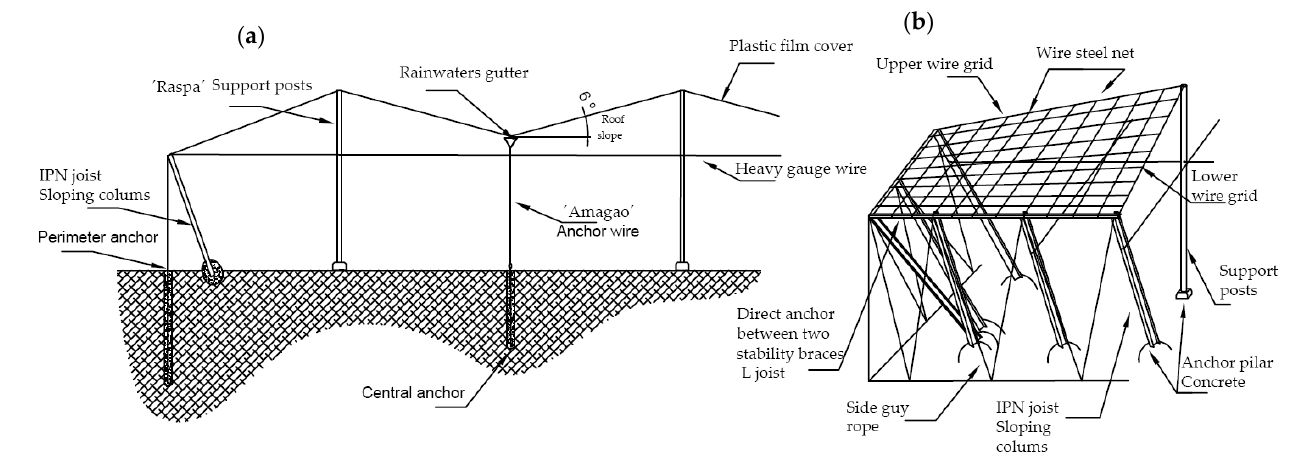
Figure 1. “ Raspa y Amagado ” greenhouse: ( a ) section; ( b ) corner greenhouse details.